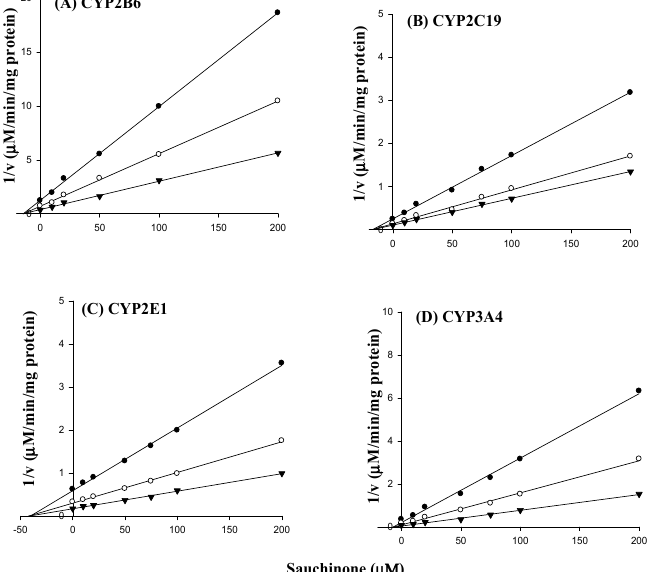
Figure 2. Dixon plots for inhibitory e ff ects of sauchinone at various concentrations ( ● , 20 μ M; ○ , 50 μ M; ▼ , 200 μ M) on CYP2B6 ( A ); 2C19 ( B ); 2E1 ( C ); and 3A4 ( D ) activities.